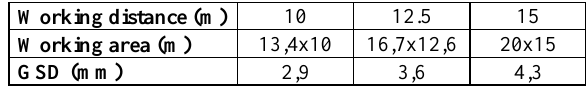
Table 2. Acquisition parameters of photogrammetric campaign.